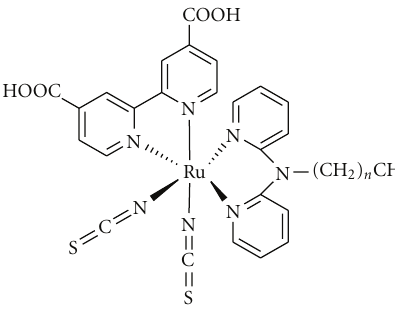
Figure 4: Molecular structures of complex I ( n = 13) and complex II ( n = 11) (taken from [20]).